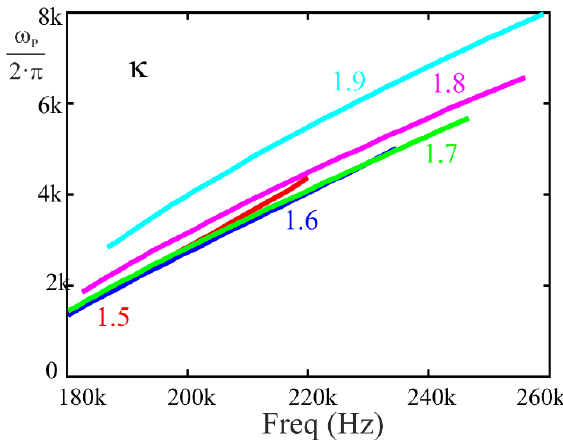
Figure 10. System pole frequency as a function of the operating frequency.